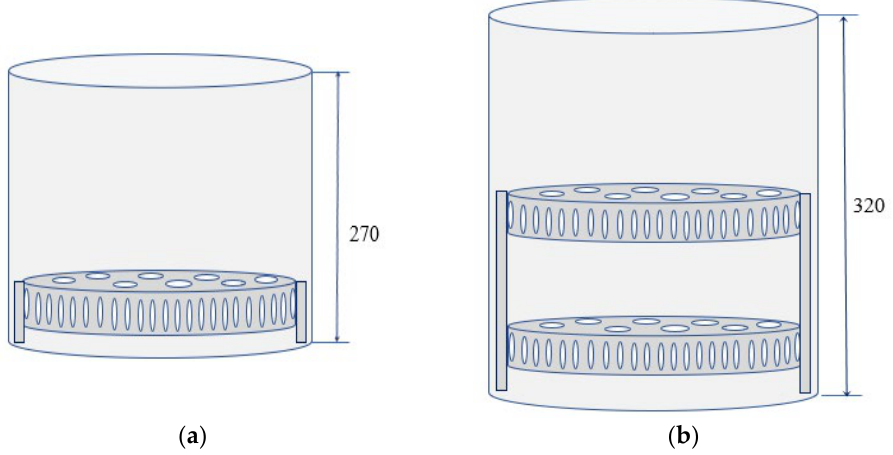
Figure 12. Sketch of the tiered fixture in the working chamber [3]: ( a ) single-tier fixture; ( b ) two-tier fixture.